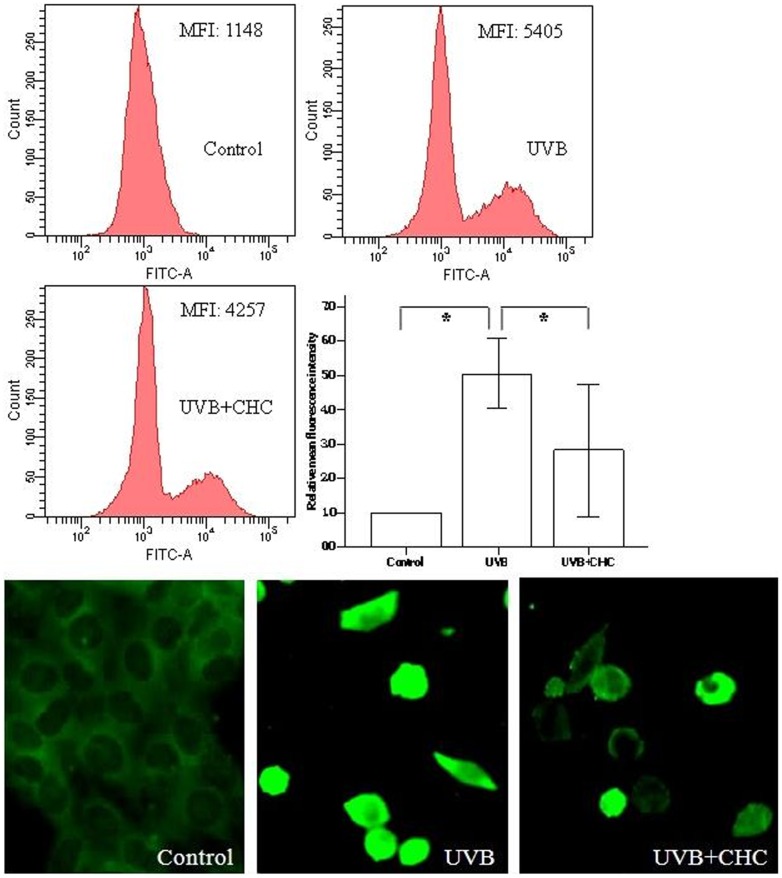
Effect of CHC on the ROS level in RGC-5 cells 24 h after UVB exposure as revealed by flowcytometry and fluorescence microscopy.RGC-5 cells exposed to UVB insult exhibited intense green fluorescent staining. 10 µM CHC clearly blunted the accumulation of ROS in UVB-exposed RGC-5 cells. Data were expressed as means±S.D. (*P<0.05).